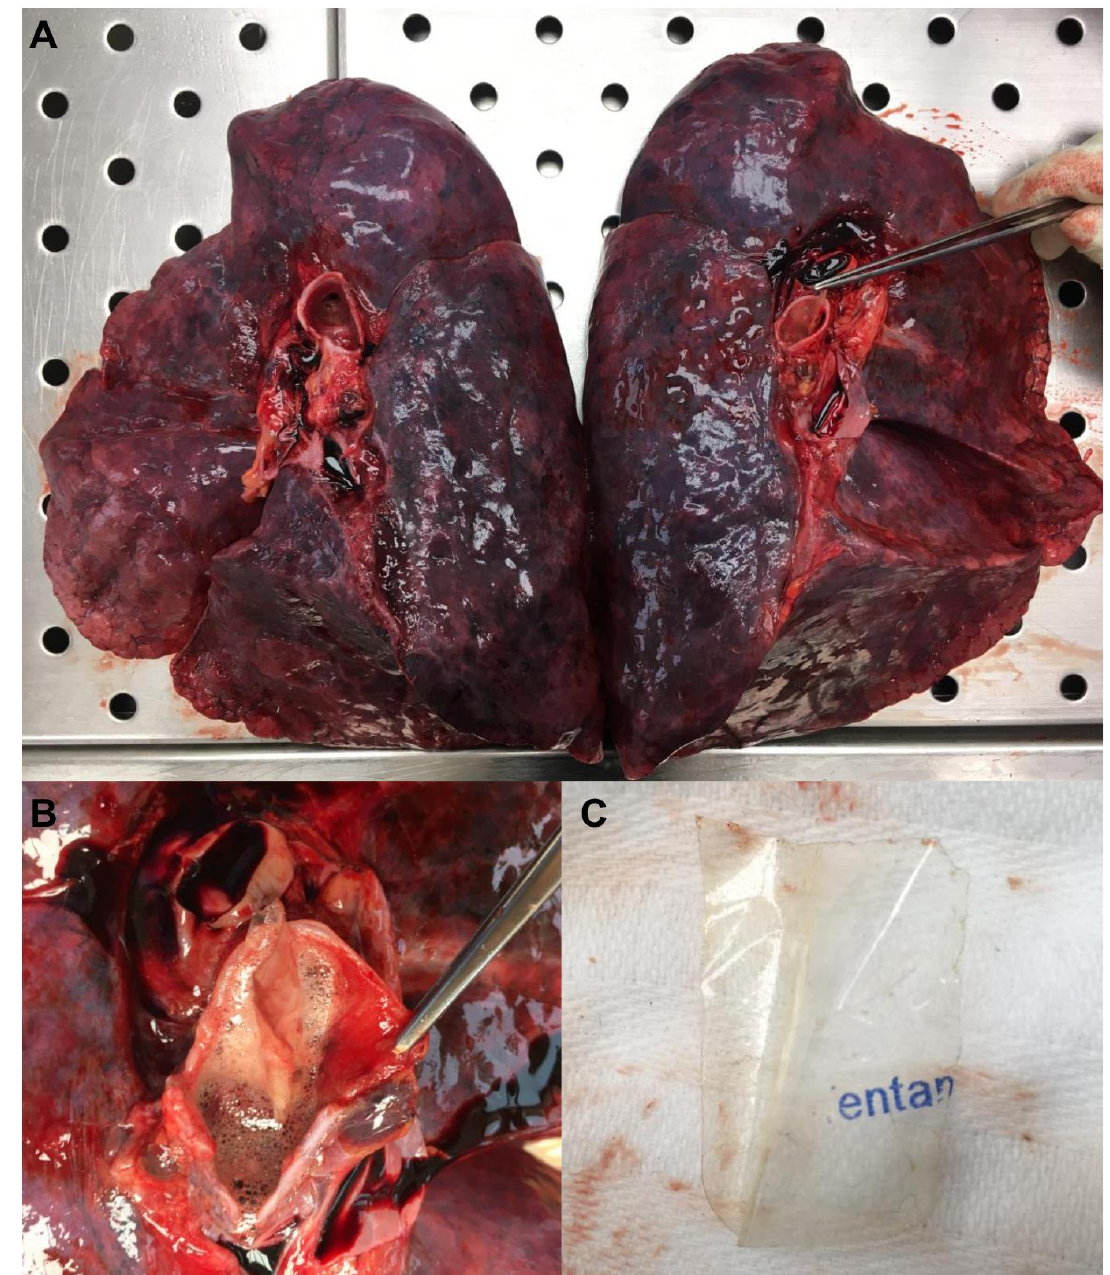
Figure 1. Autopsy Findings: ( A ) Macroscopic aspect of lungs. ( B ) Detail of left bronchus with fentanyl patch protective film. ( C ) Fentanyl patch protective film.